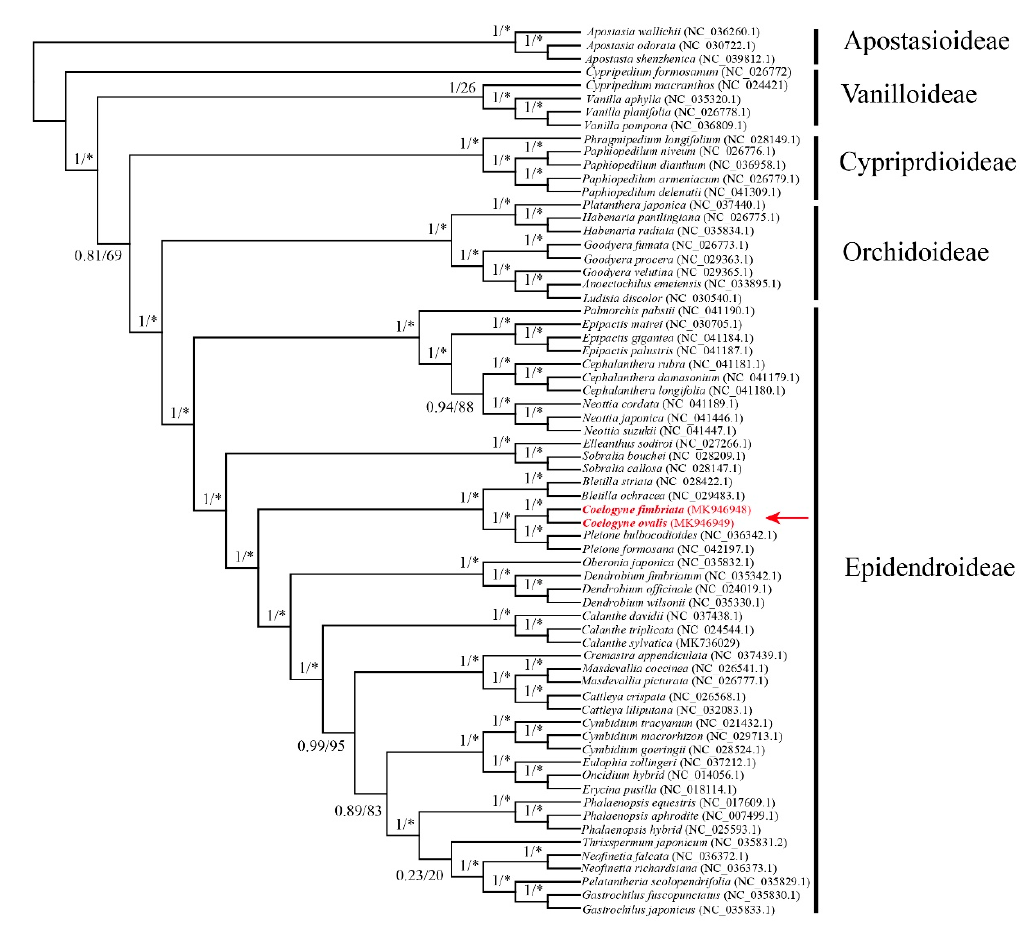
Figure 5. The phylogenic relationship of 67 Orchidaceae species with Maximum Likelihood (ML) and Bayesian analysis. * indicated 100 percent of bootstrap support using ML analysis.